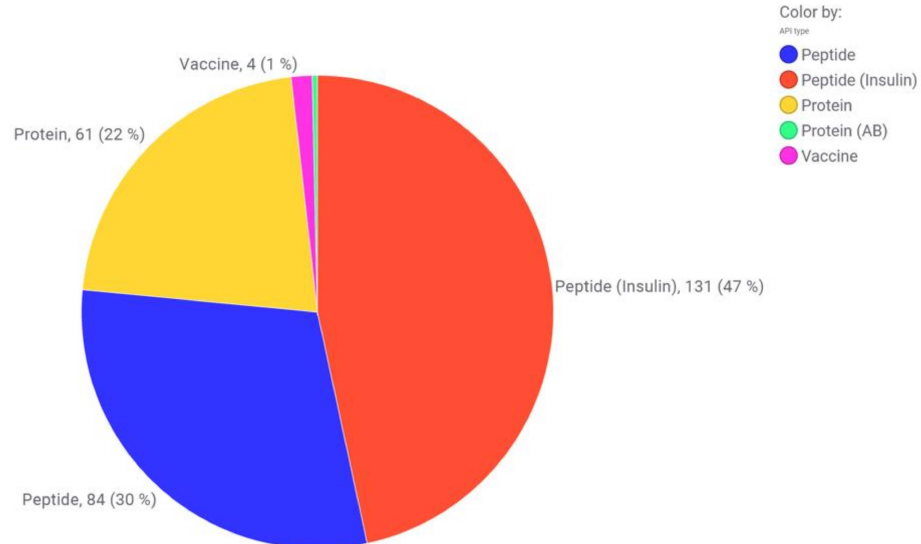
Figure 7. Distribution of market products related to APIs containing preservatives. A peptide length of 100 amino acids was used to discriminate between protein and peptide. 47% of the market products found contain insulin. Of minor importance are vaccines (4 matches) and antibody (AB) formulations (1